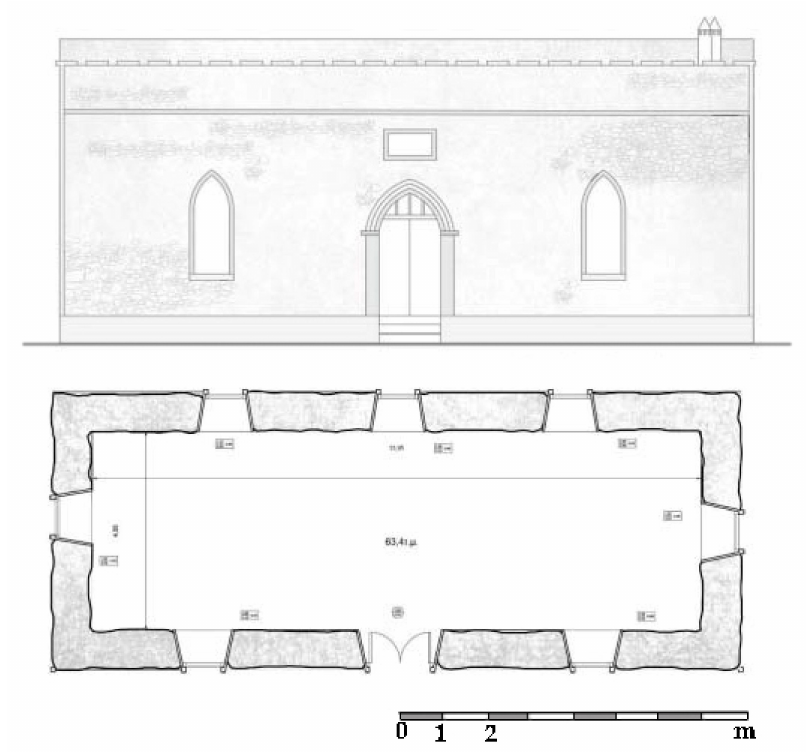
Figure 16. Façade and ground plan of the English School of Kato Chora in Kythera, Greece.